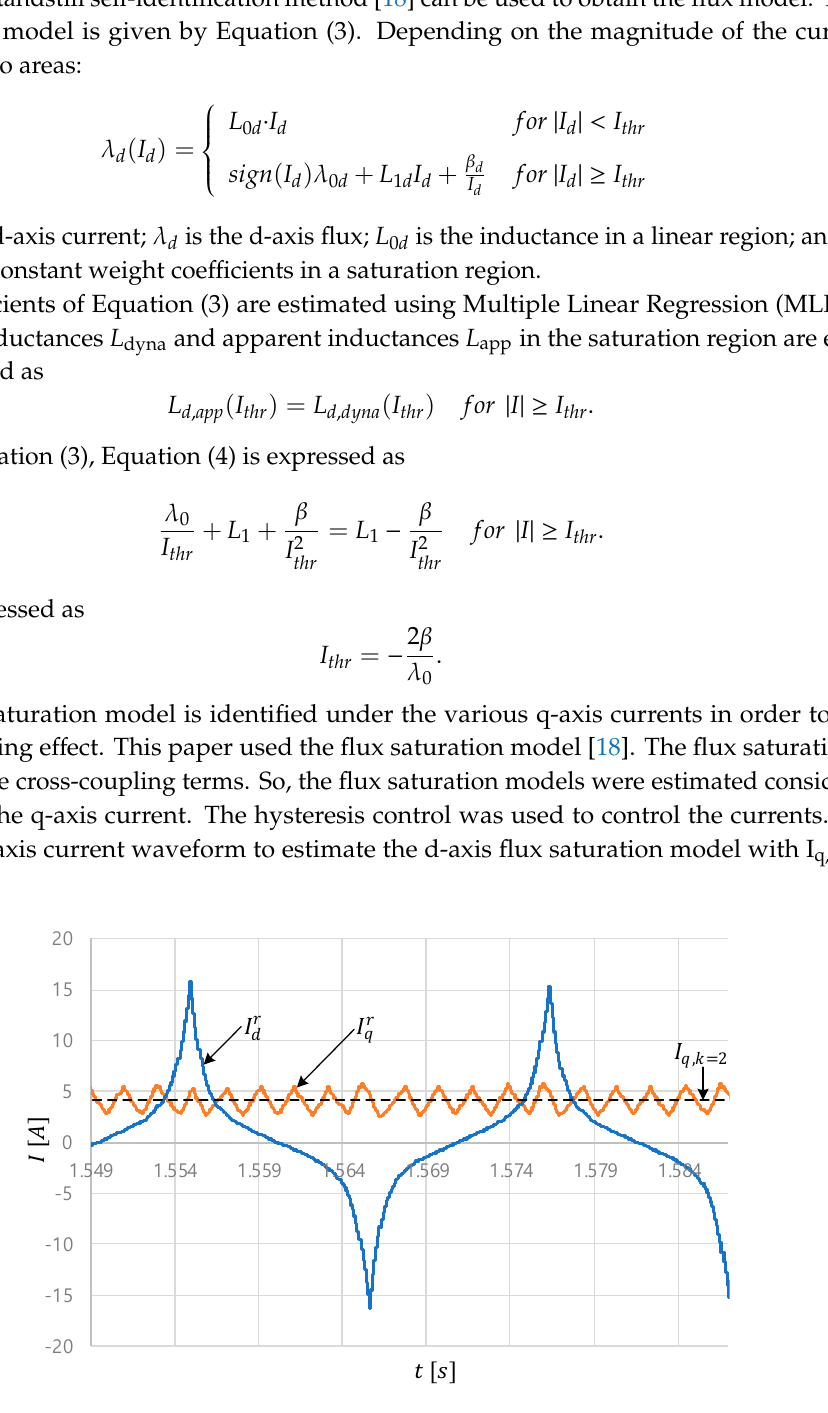
of k = 2 and M = 5. q,k